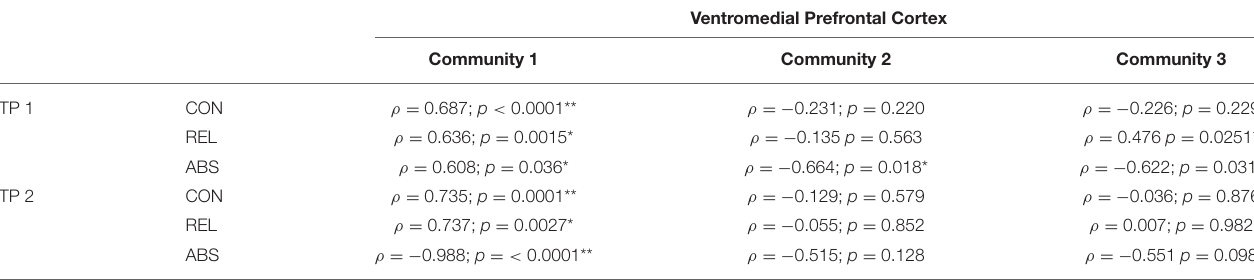
TABLE 5 | Results of the post-hoc tests – Over-Integration of the ventromedial PFC in relation to the three community-structure.